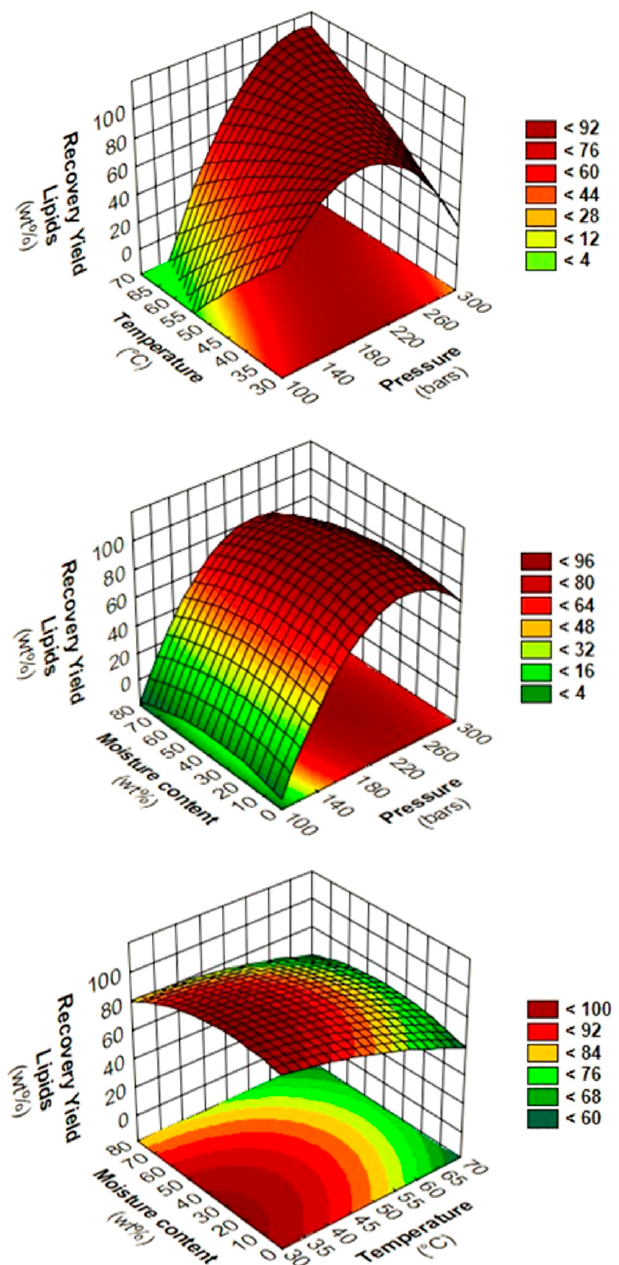
Figure 1. Response surfaces and contour plots of two-way interactions between pressure/temperature ( top ) at 40 wt% moisture content, pressure/moisture content at 50 °C ( middle ) and temperature/moisture content at 200 bars ( bottom ) for RYL of SC-CO 2 extraction from SCG.